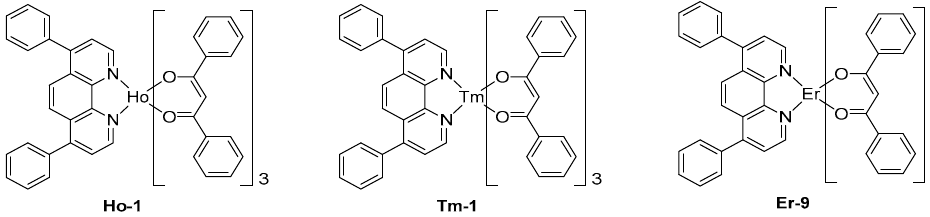
Figure 11. Other Lanthanum-based near-infrared (NIR) emitters for light-emitting diodes.